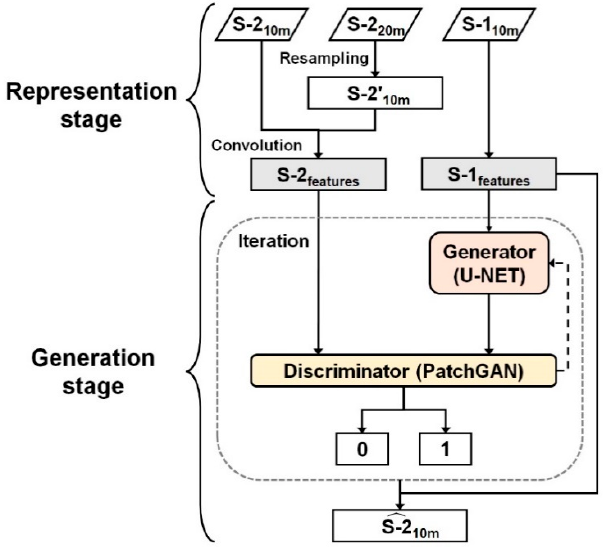
Figure 6. Two-stage CGAN model applied in this study (S-2—Sentinel-2 optical image; S-1—Sentinel-1 SAR image).